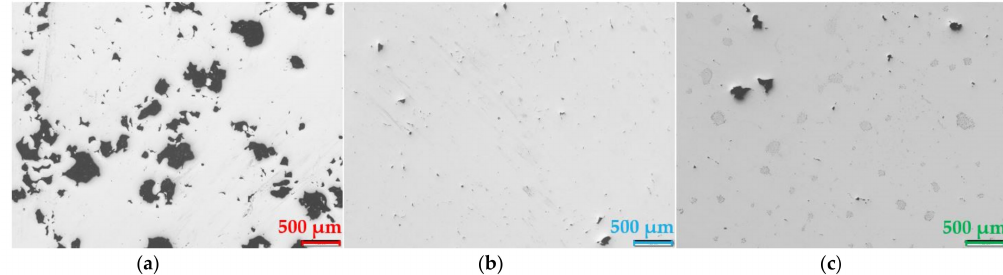
Figure 8. Optical micrographs of unetched L-PBF 18Ni300 as-built samples printed with ( a ) hexagonal, ( b ) parallel stripes and ( c ) chessboard strategies.